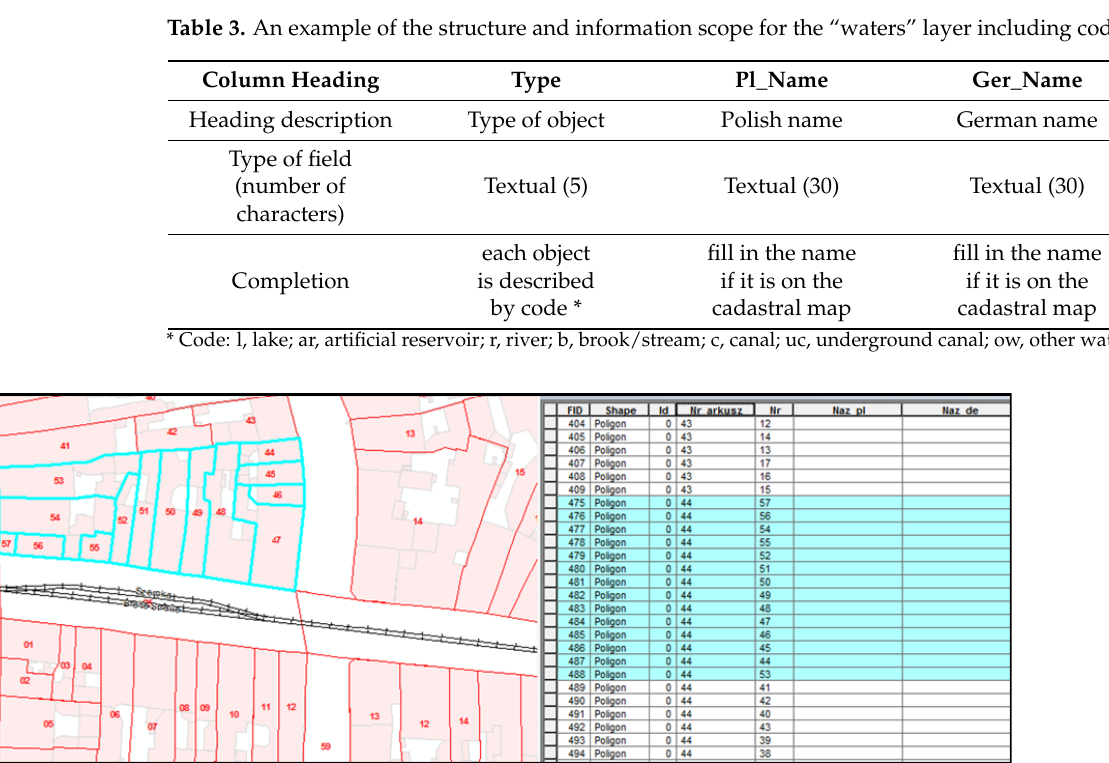
Figure 11. Attribute table structure with highlighted rows and corresponding vector data using the example of the “plots” information layer. Table 2. An example of the structure and scope of information for the “build - up area” layer includ- ing coding.